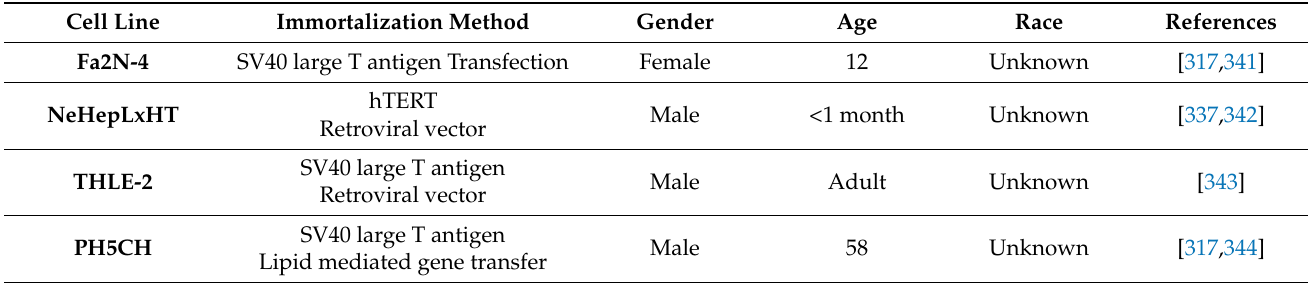
Table 9. Overview of commonly used immortalized human liver cell